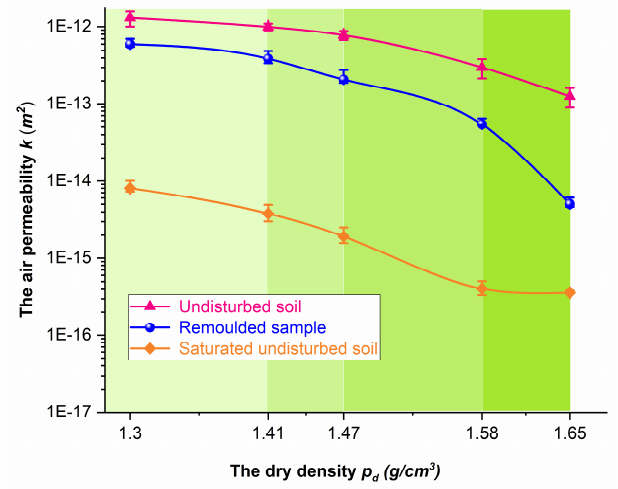
Figure 11. The air permeability of undisturbed, undisturbed saturated, and remolded loess samples (the dry density and moisture content of the remolded loess samples were consistent with those of the undisturbed loess samples).